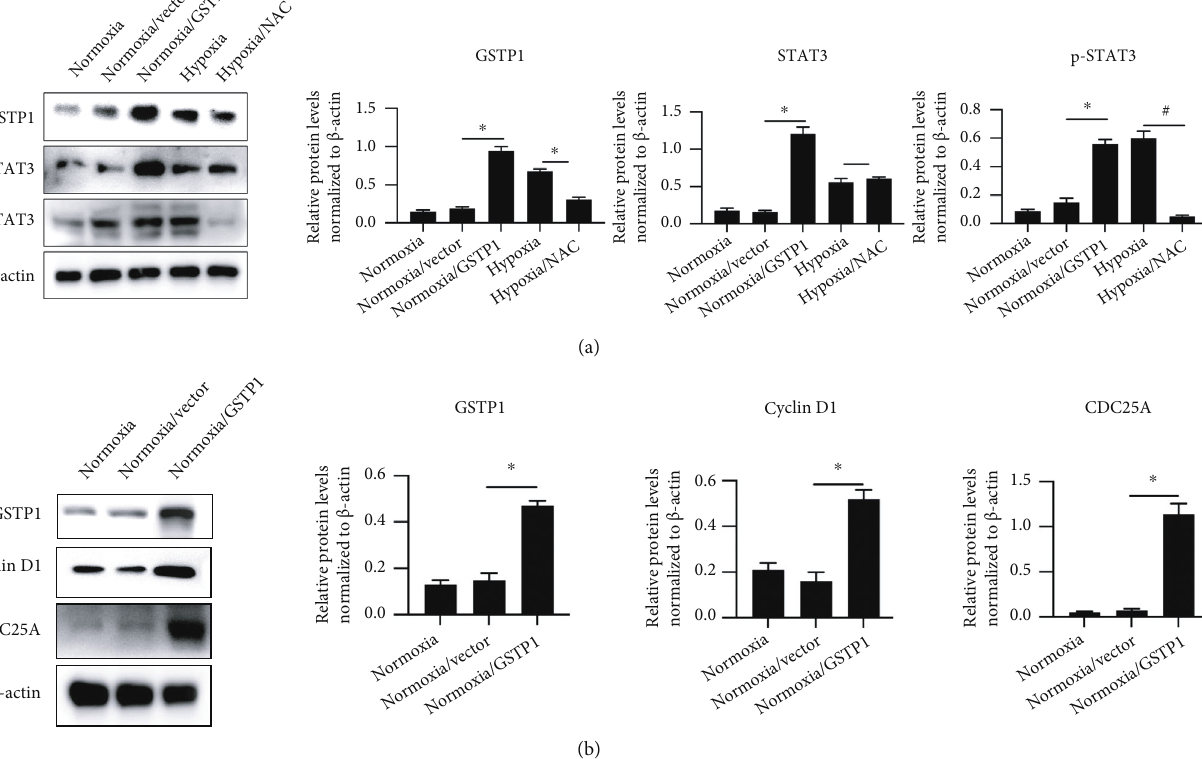
Figure 6: Overexpression of GSTP1-stimulated STAT3/Cyclin D1 signaling. (a) After being cultured under normoxia or hypoxia for 24 hours, GSTP1, STAT3, and phosphorylation of STAT3 (p-STAT3) were detected by performing western blot. * P < 0 : 05 , vs. normoxia/ vector group; # P < 0 : 05 , vs. hypoxia group. (b) After GSTP1 overexpression, downstream genes of STAT3, including cyclin D1 and CDC25A were detected by performing western blot. * P < 0 : 05 , vs. normoxia/vector